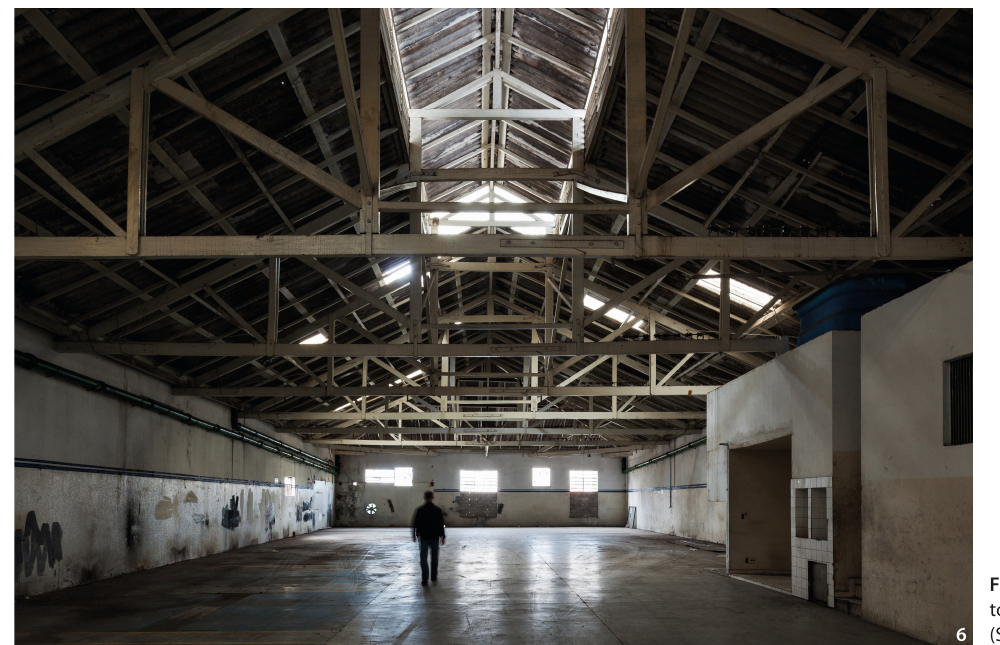
Figure 6 Shed previous to the restoration work (Source: Nelson Kon,